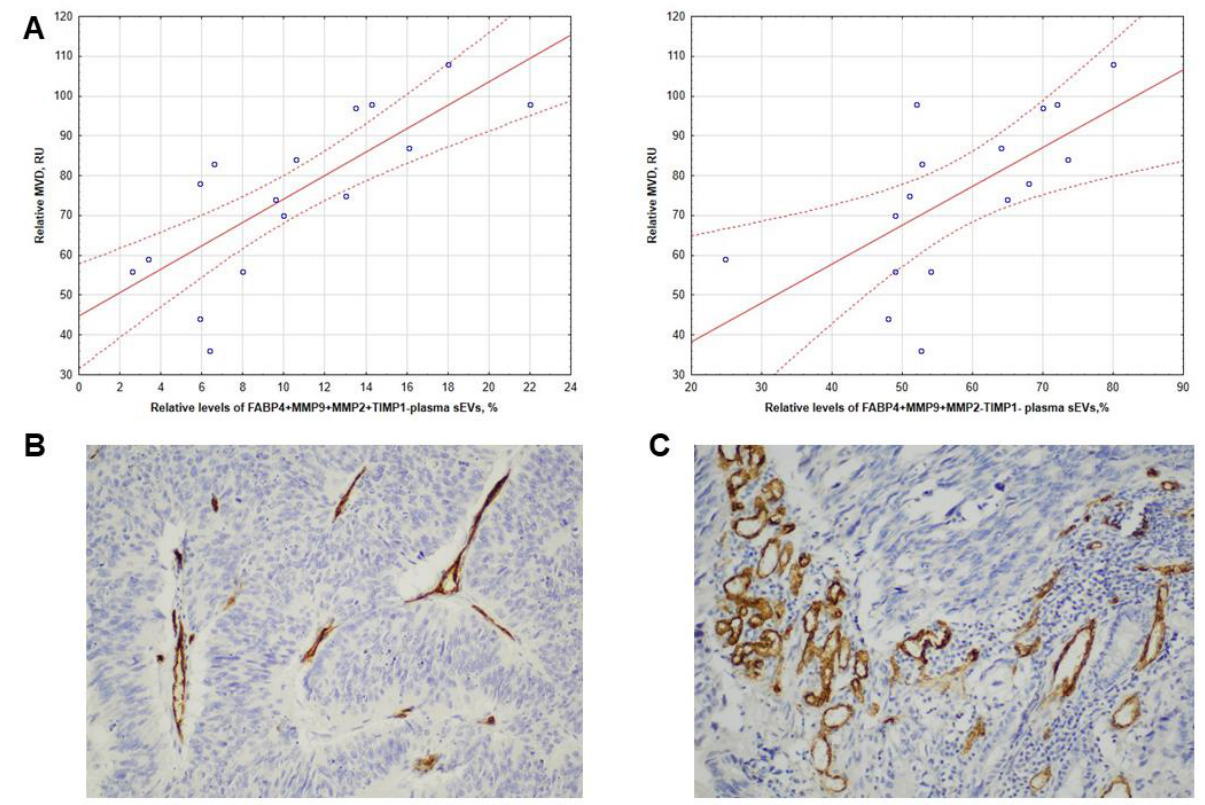
Figure 3. Correlation of FABP4-positive plasma sEVs in CRCPs with intratumoral microvascular density (MVD). ( A ) Correlation of FABP4+MMP9+MMP2+TIMP1 - ( left ) and FABP4+MMP9+MMP2 - TIMP1 - ( right ) plasma sEVs levels with intratumoral MVD; the photographs are from two representative CRCPs; ( B ) case 1 (pT3N0M0, stage II) exhibited low MVD in the stroma of a colorectal adenocarcinoma, and ( C ) case 2 (pT3N2M0, stage III) showed high MVD. immunohistochemistry (CD31). ×200. MDV expressed in relative units (RU) is presented as described above.